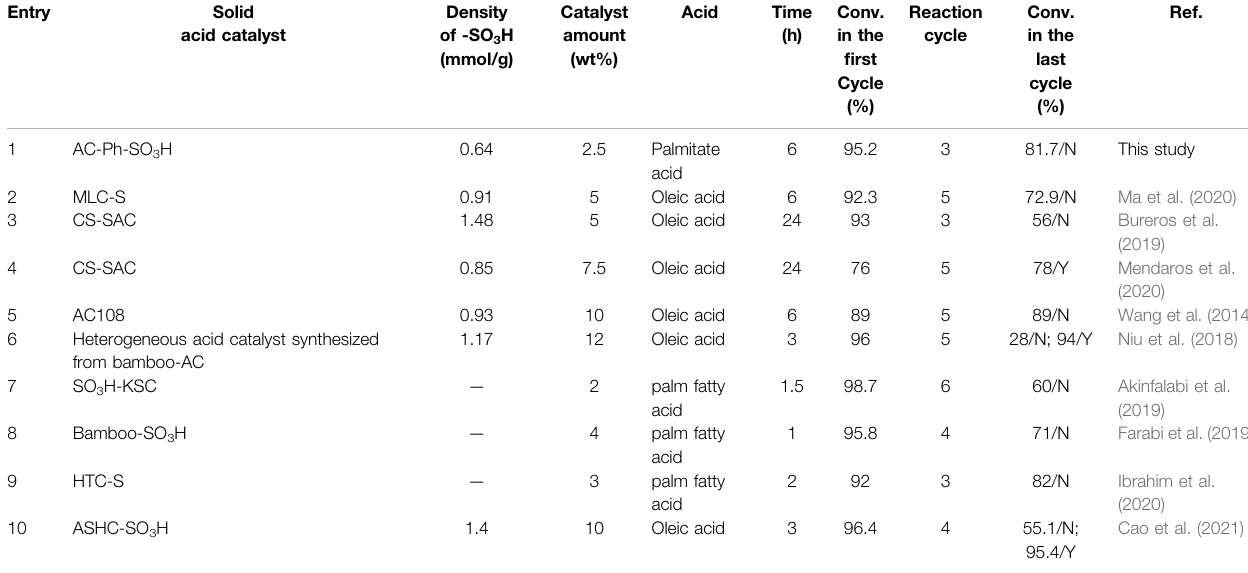
TABLE 6 | Comparison of catalytic performance with the reported carbon-based solid